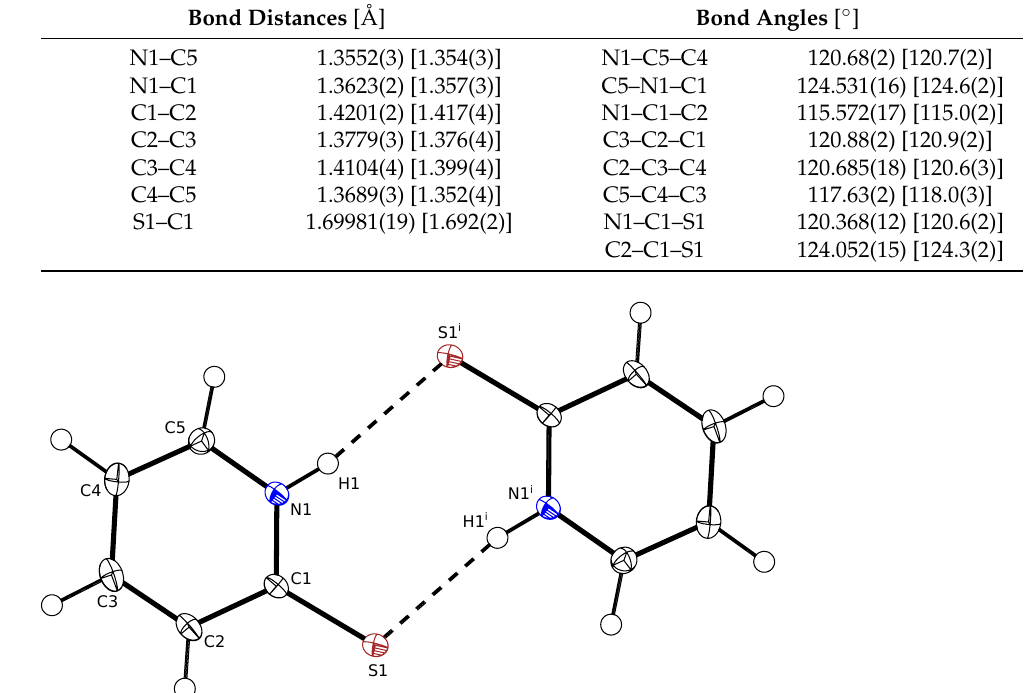
Figure 1. Hydrogen-bonded dimer in the crystal structure of (I) . Result of the SHELXL refinement. Displacement ellipsoids are drawn at the 50% probability level. Symmetry code i : − x ,1 − y , − z . N1–H1 0.873(7), H1 · · · S 1 i 2.414(7), N1 · · · S 1 i 3.27197(16) Å. N1–H1 · · · S 1 i 167.7(6) ◦ .